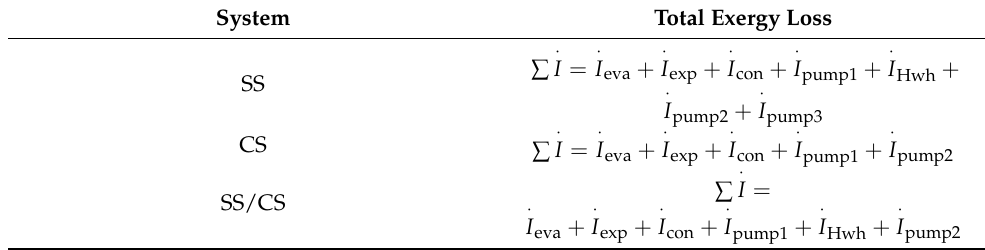
Table 3. Total exergy destruction of each